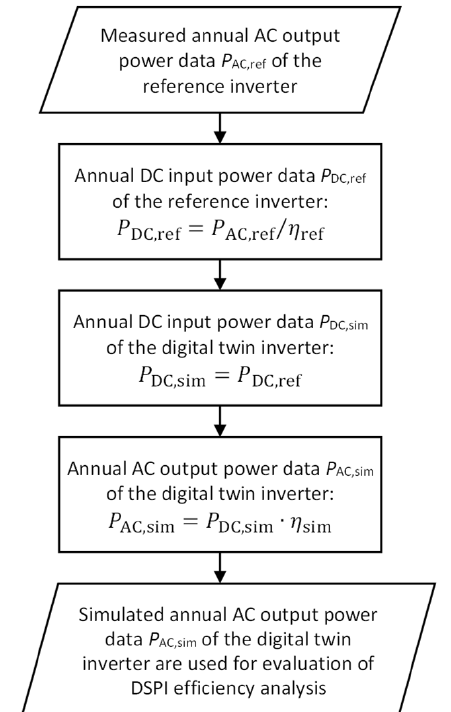
Figure 4. Algorithm for calculating the output power of the DSPI.